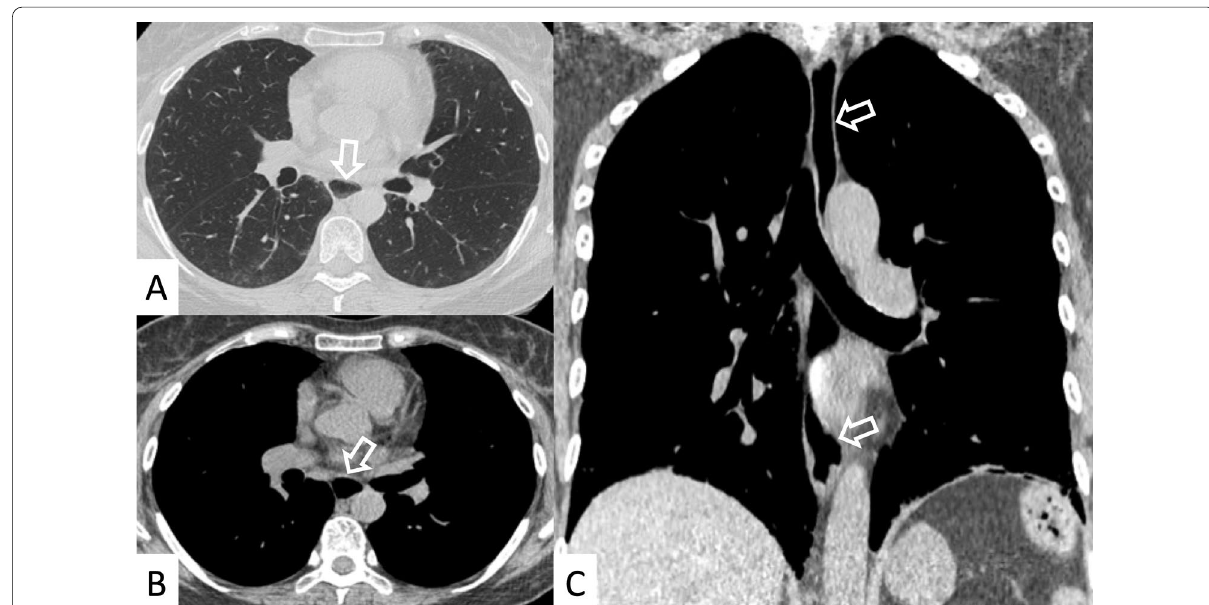
Fig. 14 Axial ( A , B ) and coronal ( C ) images of an SSc patient. Dilatation of the esophagus is clearly recognizable, being depicted (white empty arrows) in the middle and distal parts of the